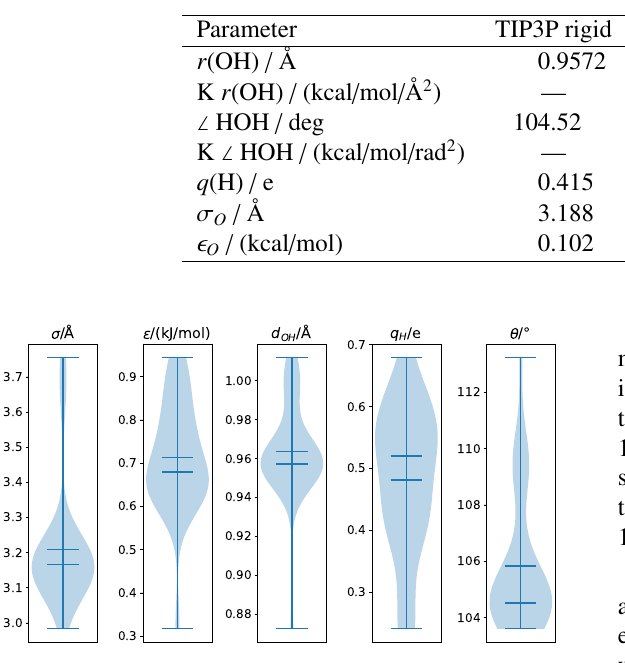
Figure 2. Violin plot of the distribution of water model parame- ters in the literature for a subset of parameters. The shaded area presents an approximated probability distribution to find a model with such a parameter value while the horizontal lines give min- imum / maximum, mean, and median of the values used in this